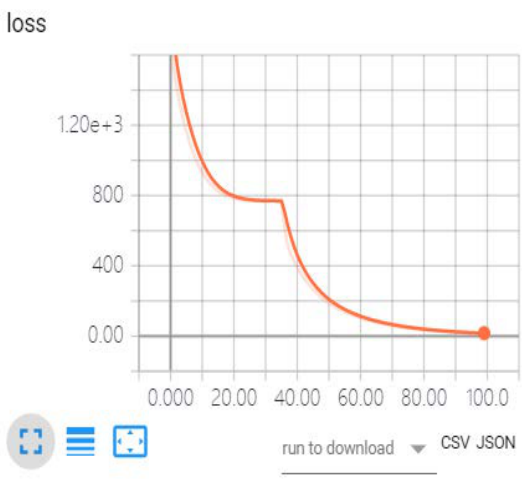
Figure 10. The loss curve graph of model.